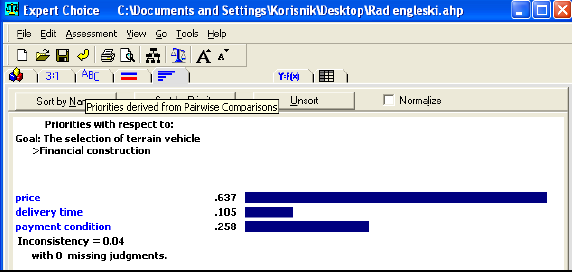
Figure 9. Finacial construction – budgeting